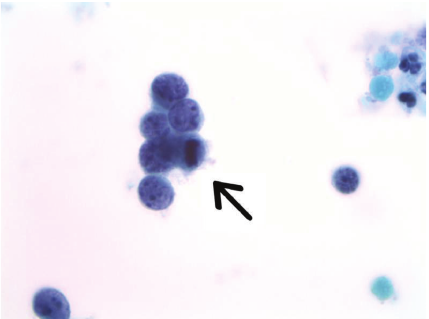
Figure 1: Lesional cells are present in cohesive aggregates as well as in singly dispersed fashions. These cells have scant, delicate cytoplasm and high nuclear/cytoplasmic ratios. The chromatin is finely granular without macronucleoli. A metaphase mitosis is noted (arrow) (Papanicolaou stain, ThinPrep,